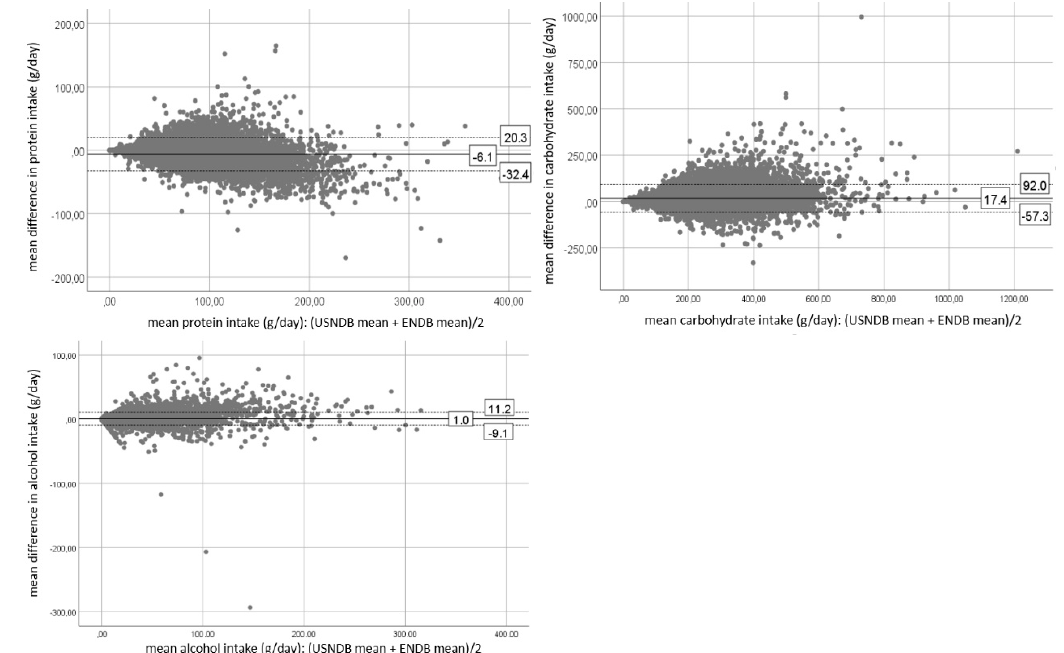
Figure 1. Bland-Altman plots for the 24-hour dietary recall (24-HDR) data representing the mean differences and their limits of agreement for energy, total fat, proteins, carbohydrates and alcohol intakes between the U.S. nutrient database (USNDB) and the EPIC nutrient database (ENDB). The mean difference is represented by the full line, the upper and lower limit of agreement are presented by dotted lines.